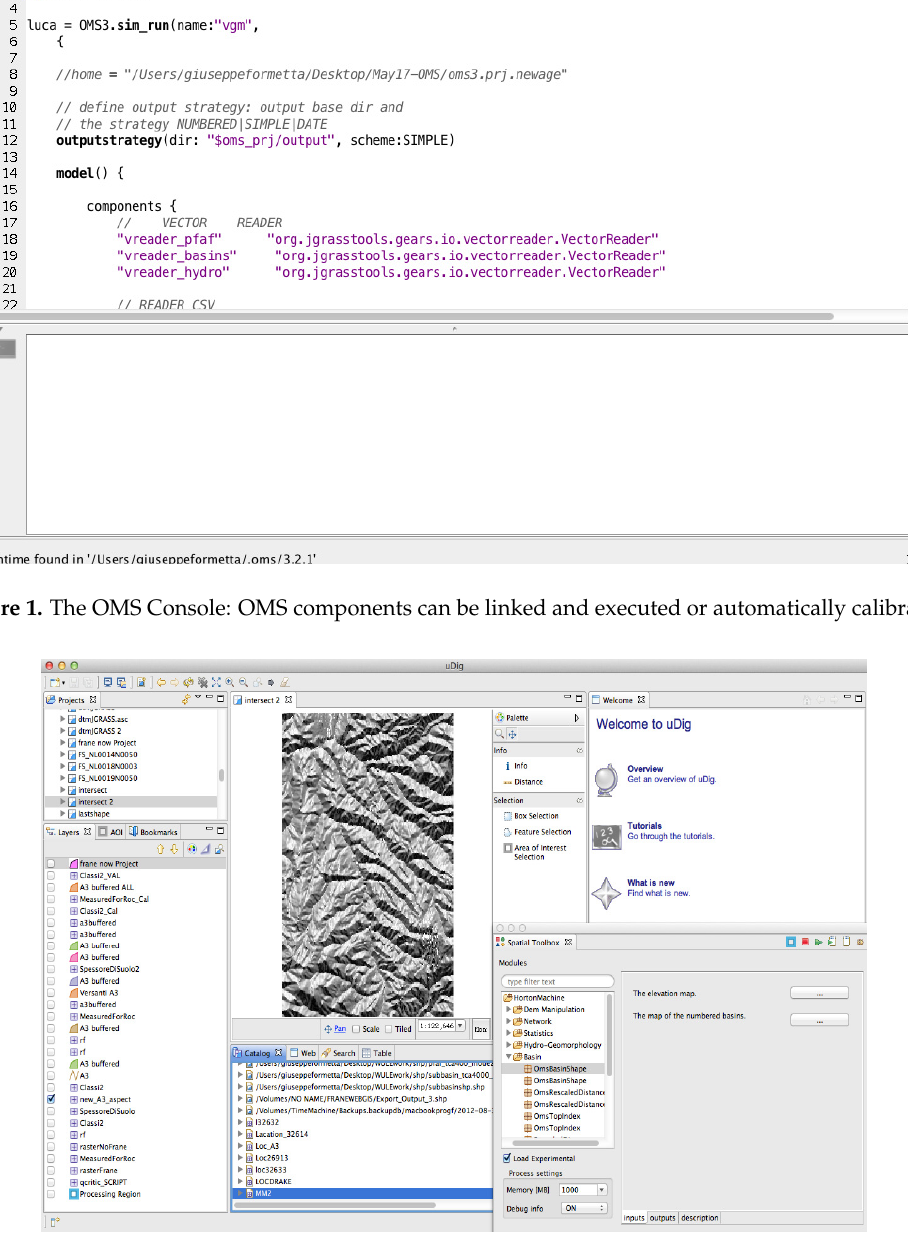
Figure 2. The uDig GIS interface: (i) the layer view (on the left ) where maps are loaded to be visualized (ii) the map view (in the center ) allows us to visualize, modify, and query rasters and vectors; the Spatial Toolbox on the right allows the user to execute OMS components.